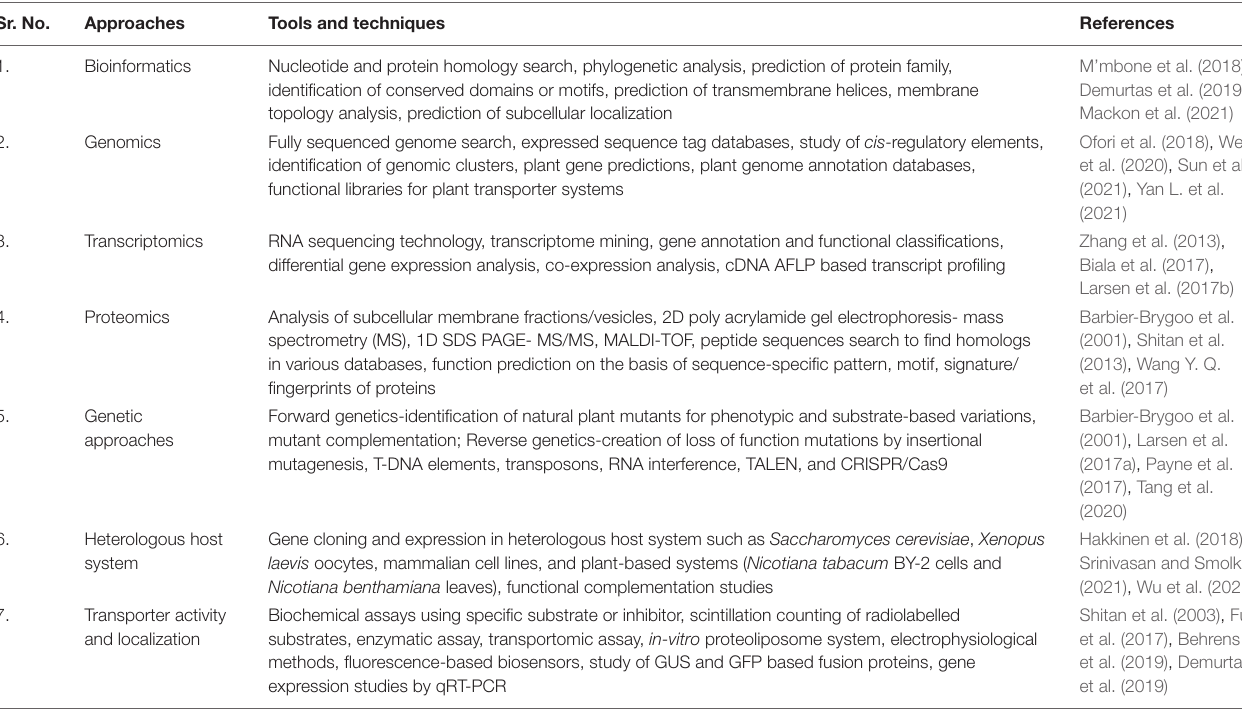
TABLE 1 | Potential in silico and experimental approaches for the identification, functional annotation, and characterization of various plant secondary metabolite transporters. Sr.